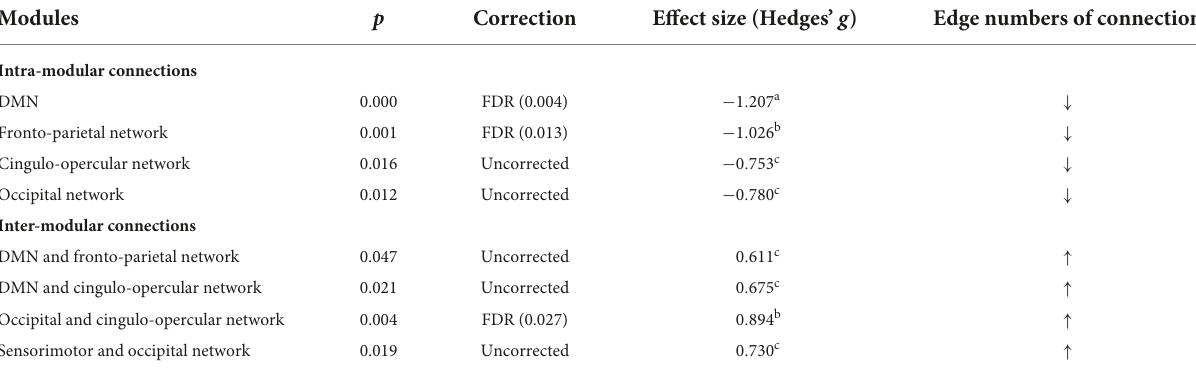
TABLE 2 The altered edge numbers of connection within or between